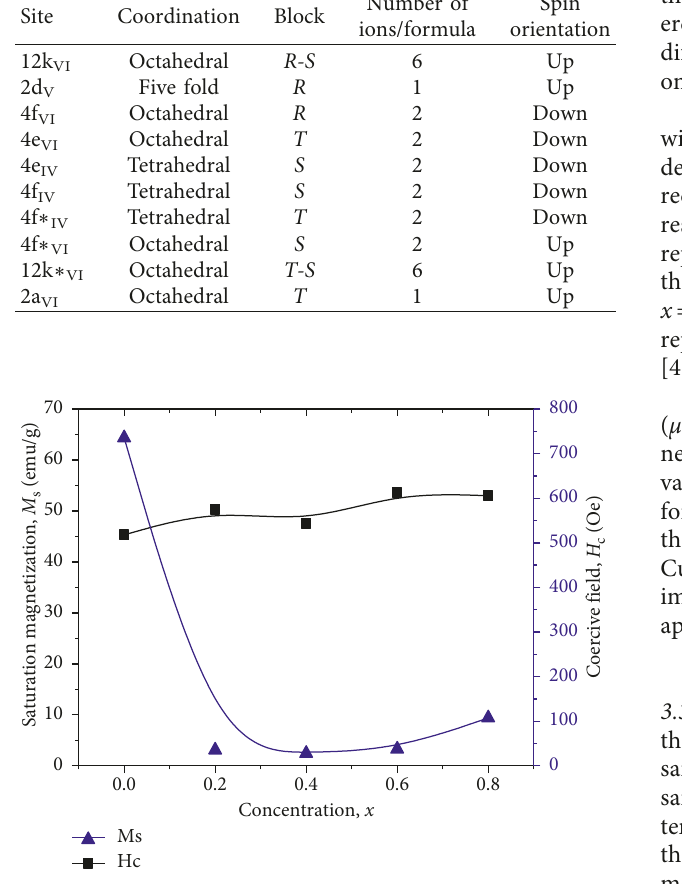
Figure 6: The saturation magnetization and coercivity as a function of concentration ( x ).